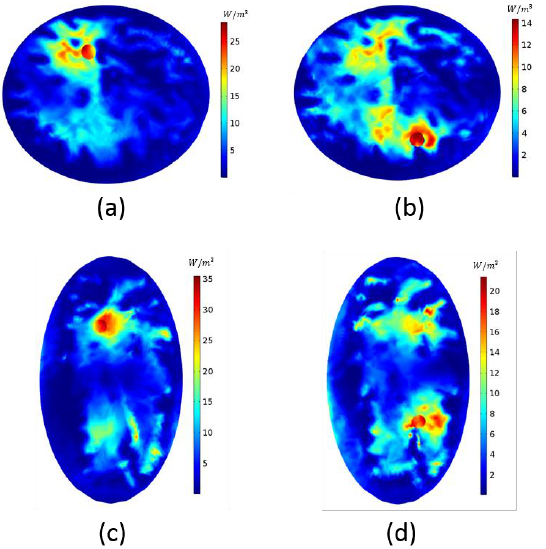
Figure 4. Heating potential of ( a , b ) breast model-I with different tumor locations; ( c , d ) breast model-II with different tumor locations.